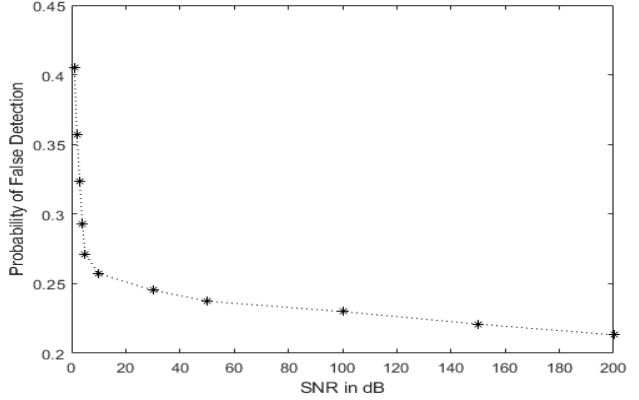
Figure 9. Probability of false detection against SNR.